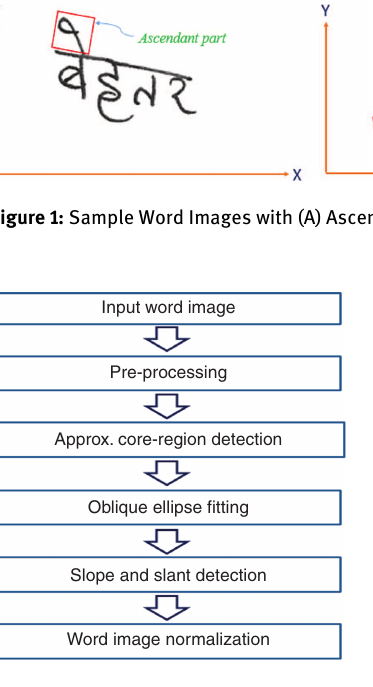
Figure 2: Block Diagram of Proposed Method.